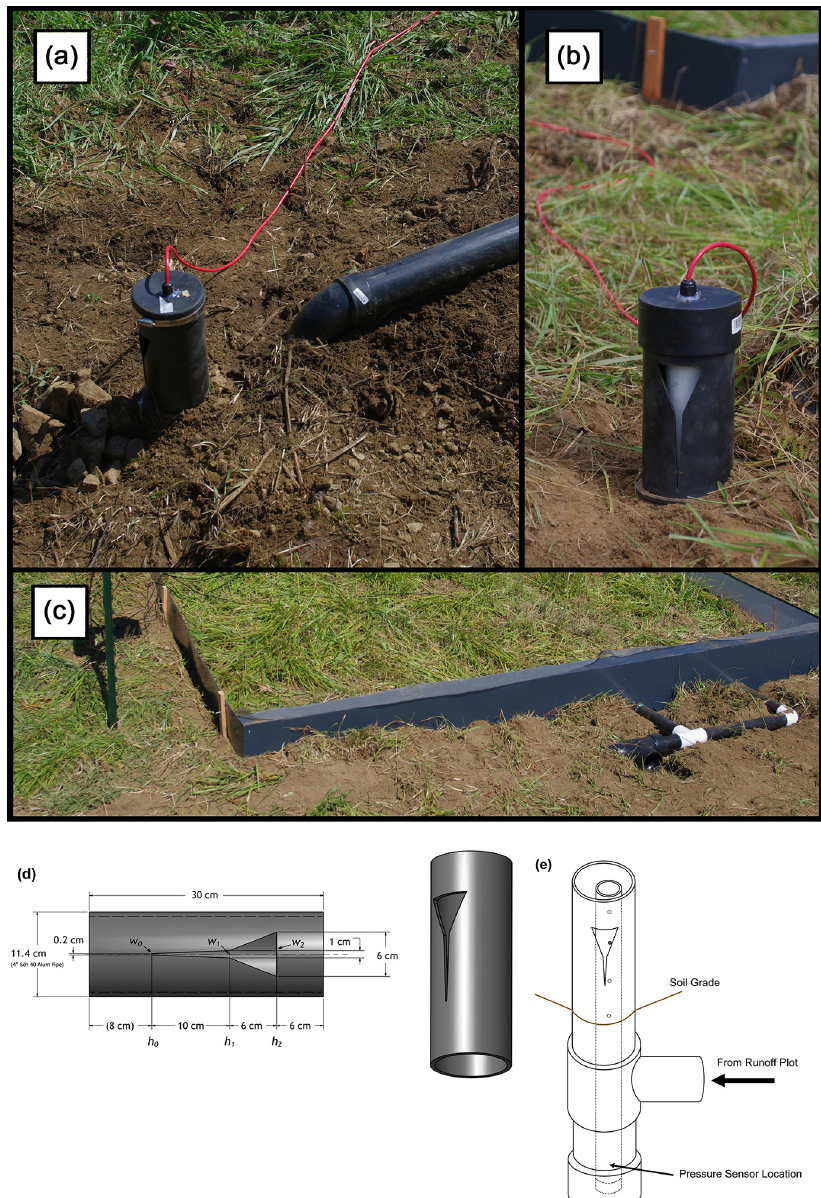
Figure 1. (a, b) Examples of UBeTubes installed below runoff plots; (c) connection between the runoff plots and the UBeTube system; (d) dimensions of the slot asmachined (modified with permission from Christopher CNC); and (e) schematic of the instrument setup.